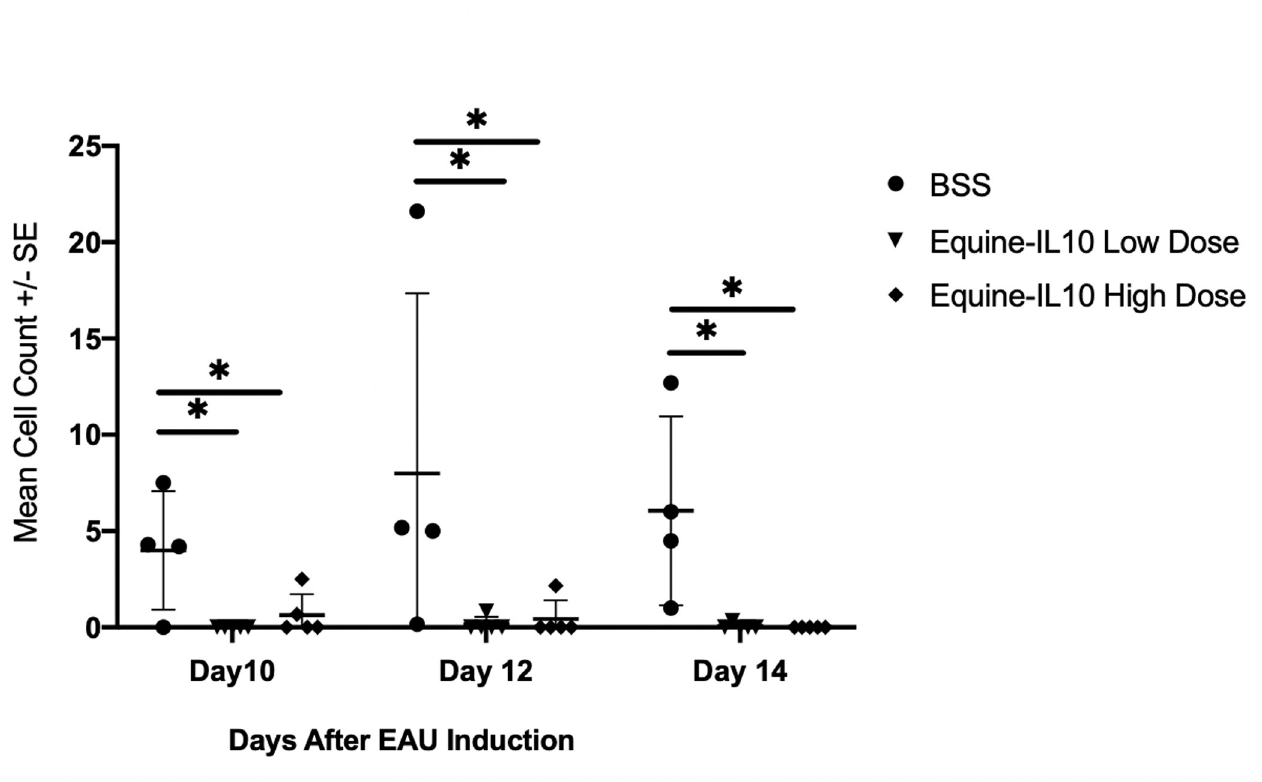
Fig 2. AAV8-Equine-IL10 Improves EAU inflammatory cell count in the anterior chamber. Optical coherence tomography (OCT) was performed once prior intravitreal injections, once prior induction of EAU and then every other day following induction of EAU. (a) scatter plot of EAU inflammatory cell count of each rat revealed that there was evidence of cellular infiltrate in the anterior chamber of rats on days 10, 12 and 14 following induction of EAU. Mean inflammatory cell count were significantly less in rats treated with a single intravitreal injection of scAAV8-Equine-IL10 (high or low dose) compared to BSS rats on days 10, 12 and 14 post EAU induction (p = < 0.004 to 0.043); Pairwise Wilcoxon tests). There were no significant differences in mean inflammatory cell count between high or low dose treated rats on any